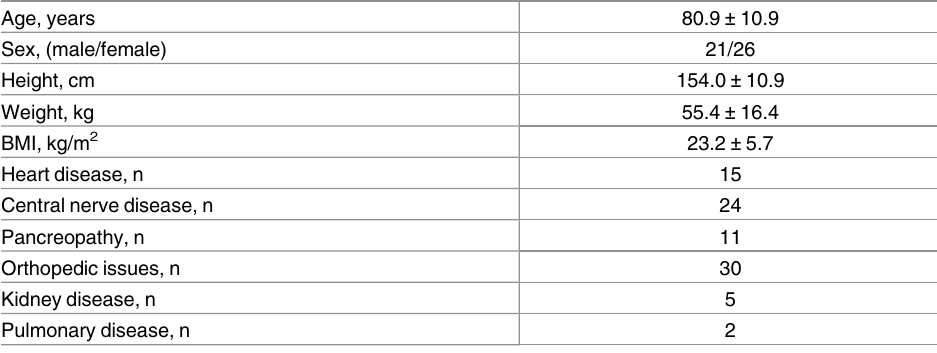
Table 2. Subjects’ characteristics (n = 47).